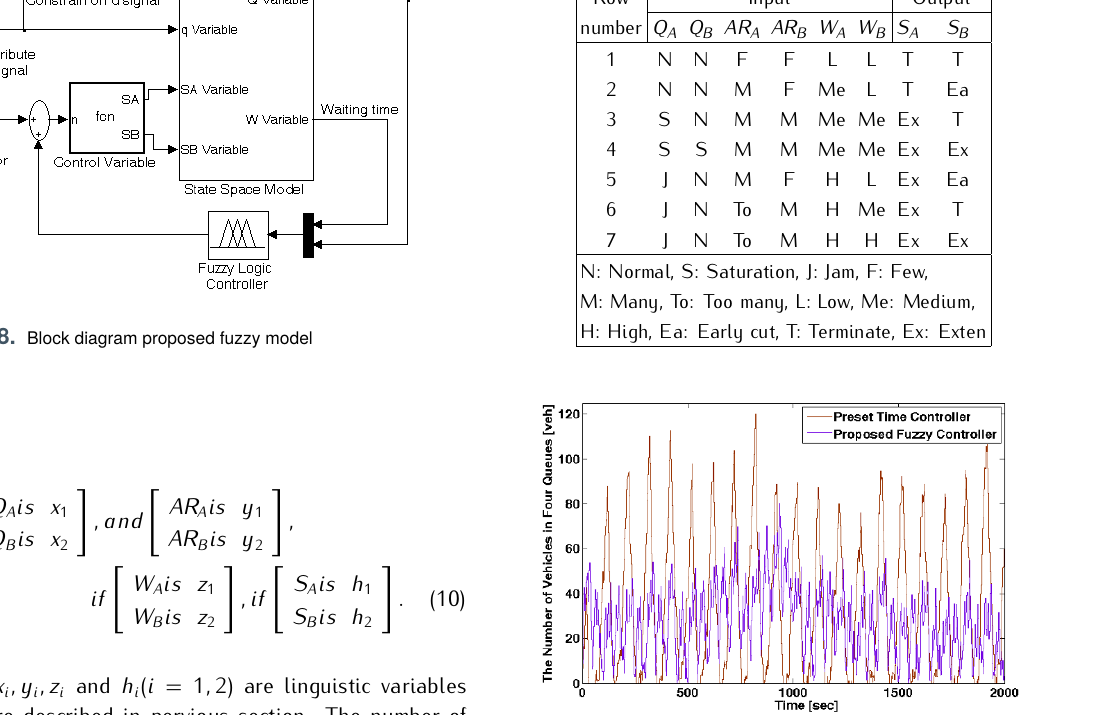
Table 2. Results for the determination of V in ten real samples and two reference materials Row